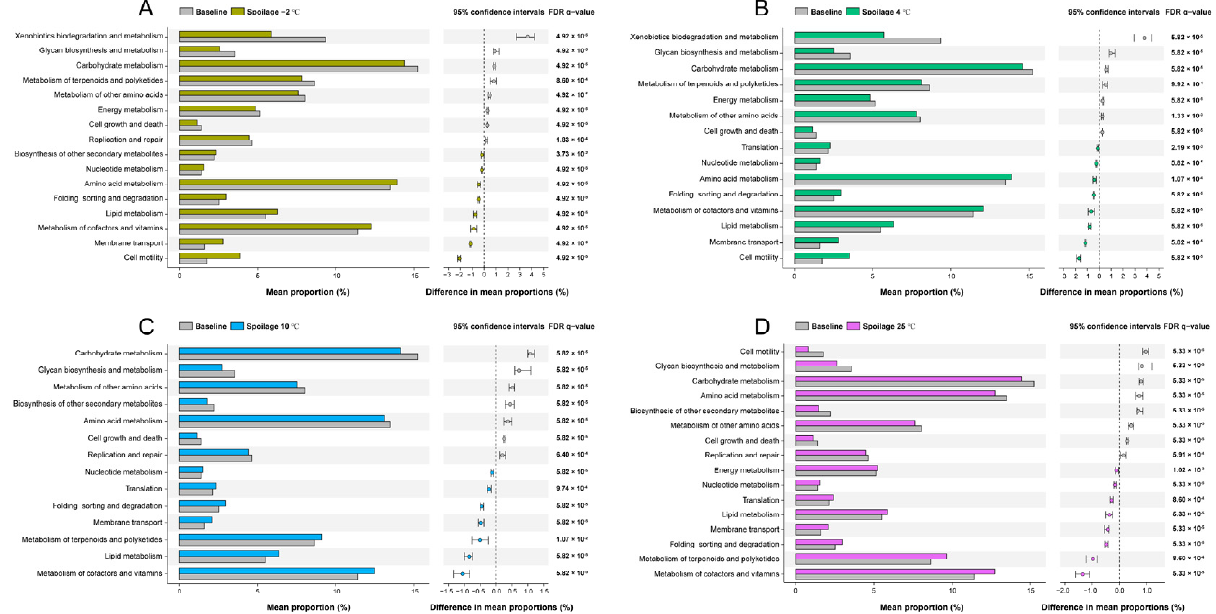
Figure 4. Metabolic pathway profile comparisons between fresh pork meat and spoiled pork meat. ( A ) Comparison between fresh pork meat and spoiled pork meat stored at − 2 °C. ( B ) Comparison between fresh pork meat and spoiled pork meat stored at 4 °C. ( C ) Comparison between fresh pork meat and spoiled pork meat stored at 10 °C. ( D ) Comparison between fresh pork meat and spoiled pork meat stored at 25 °C. Pathway comparisons were performed based on KEGG pathways (level 2).